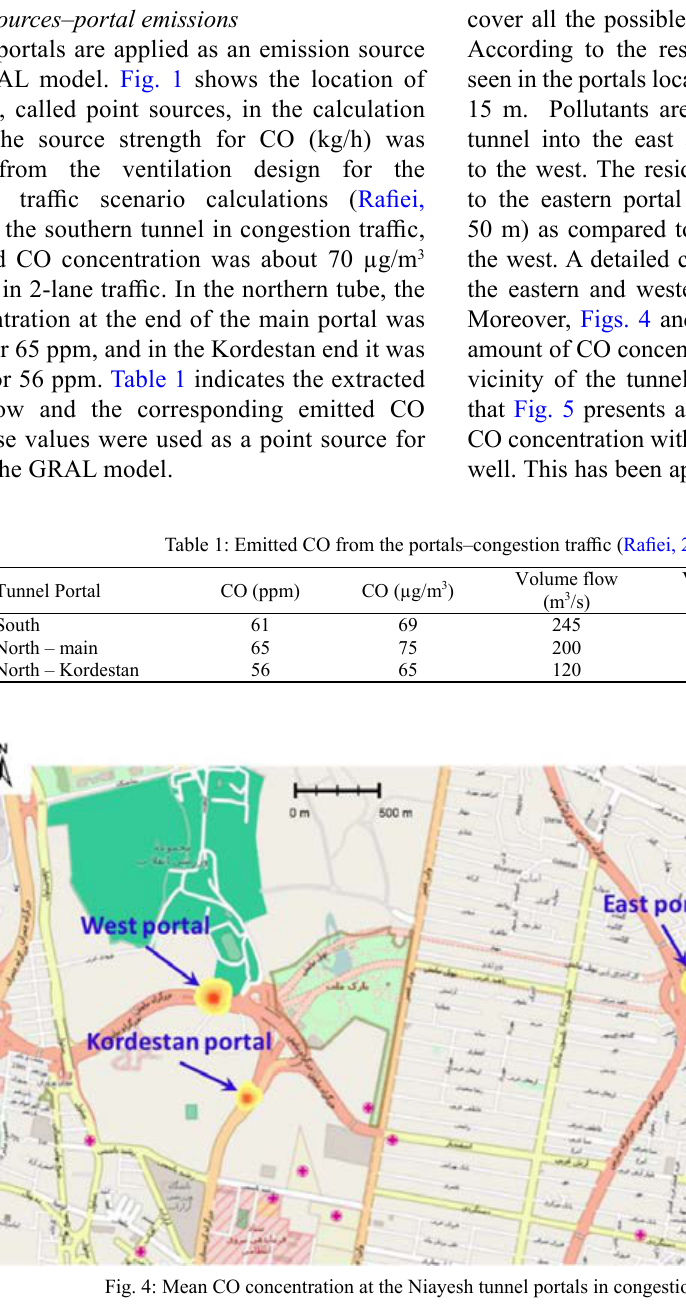
Fig. 4: Mean CO concentration at the Niayesh tunnel portals in congestion traffic–5m